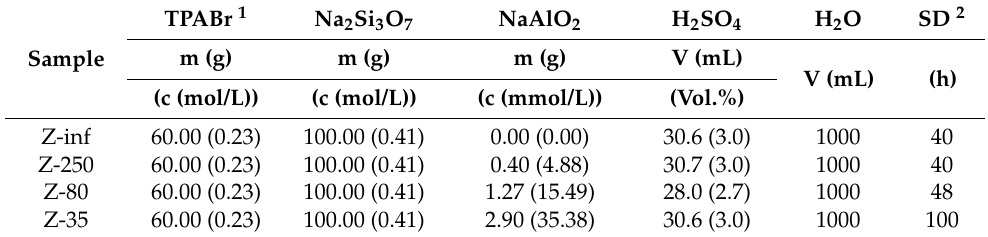
Table 4. Process parameters of hydrothermal synthesis of ZSM-5 zeolite